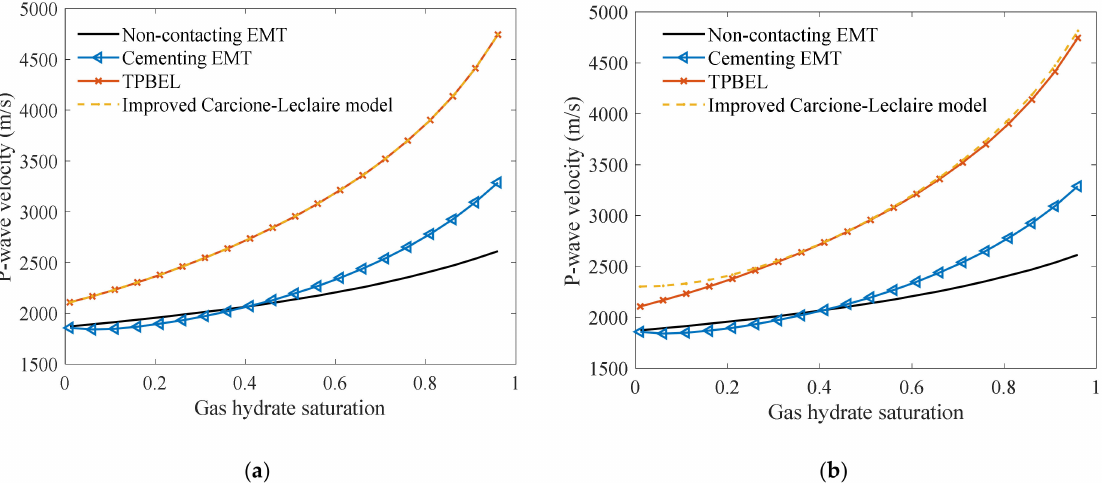
Figure A1. Variation of P-wave velocities with gas hydrate saturation in different models: ( a ) 100 Hz; ( b ) 20 kHz.